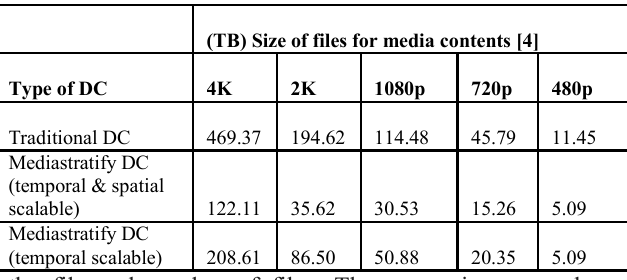
Table 3. DC sizes with and without